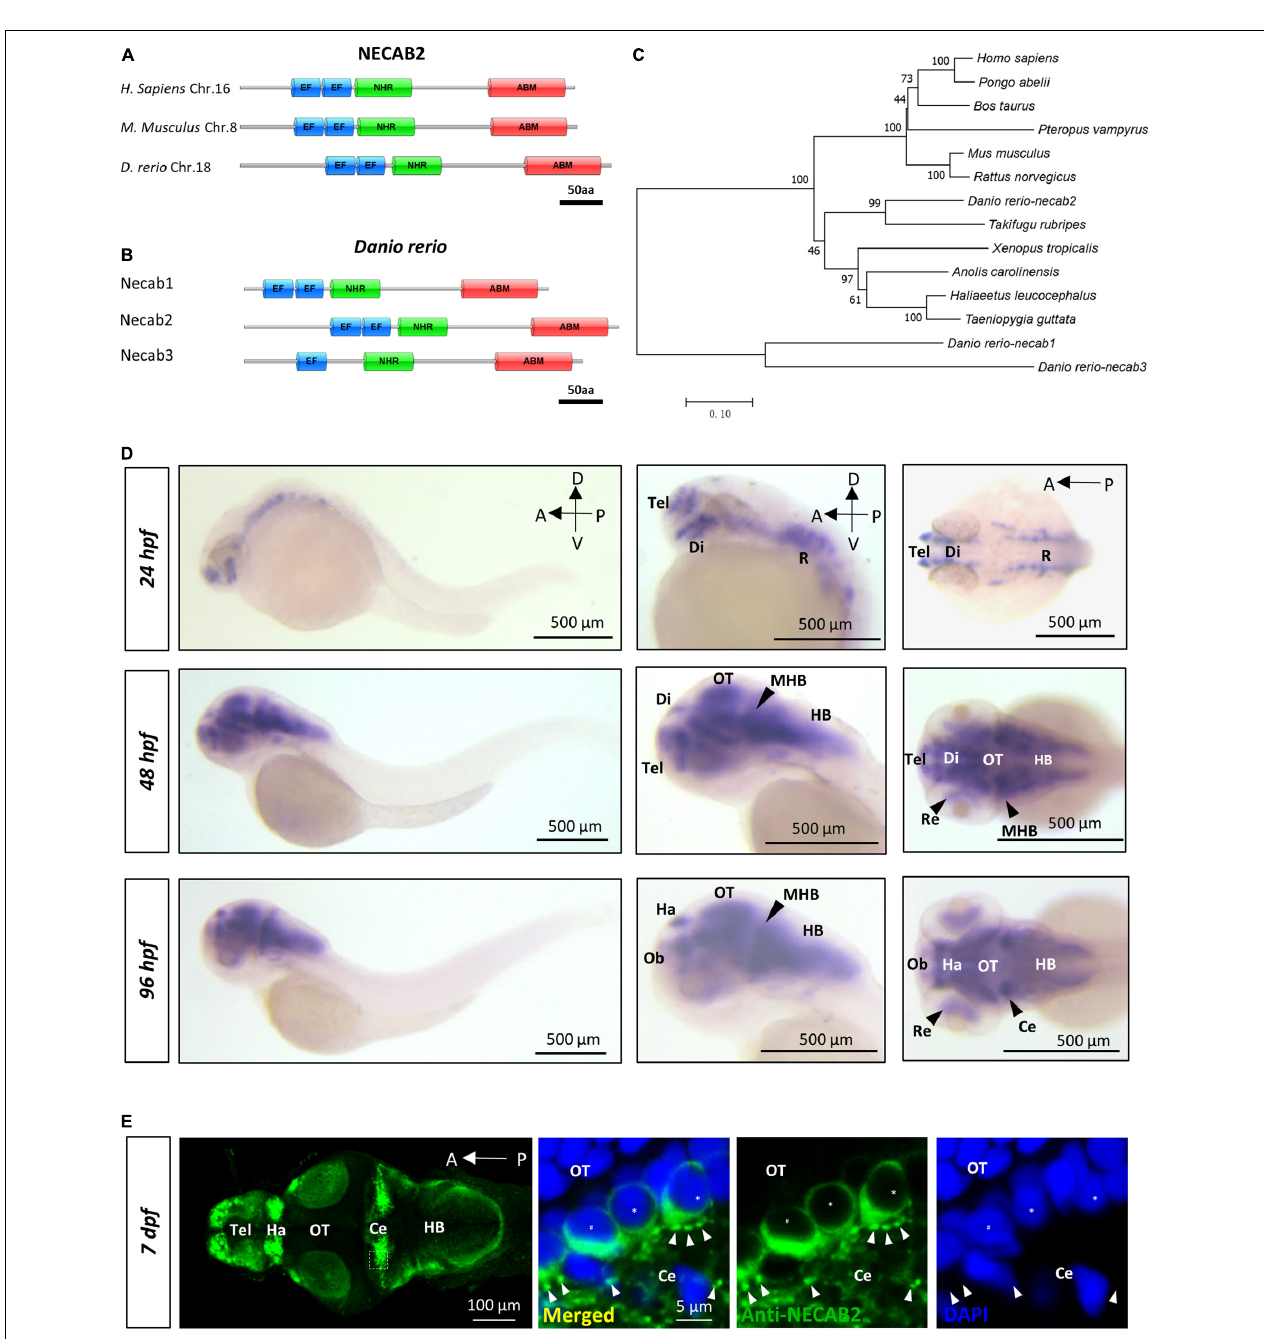
FIGURE 1 | necab2 , conserved in the vertebrate lineage, is expressed in the developing zebrafish brain. (A) Protein Diagrams of NECAB2 orthologs in H. sapiens , M. musculus, and D. rerio . Diagrams represented the longest isoform. The diagrams were denoted by the species name and chromosome number (Chr.) All major functional domains are conserved. Scale bar = 50 amino acids (aa). (B) Protein Diagrams of the Necab family in D. rerio . Diagrams represented the longest isoforms. Diagrams are denoted by the gene name. All the major functional domains were conserved in Necab1, Necab2, and Necab3. Scale bar = 50 amino acids (aa). (C) The phylogenetic tree of the evolutionary relationship of NECAB2 . Diverse animal phyla were identified by a best reciprocal BLAST search with human NECAB2 and were mapped onto a phylogenetic tree. The tree was drawn to scale, with branch lengths in the same units as those of the evolutionary distances. All of the sequences were available from the NCBI protein database. Scale bar = 0.10. (D) Whole-mount in situ hybridization of necab2 in wild-type embryos at 24, 48, and 96 hpf. necab2 was expressed in selected brain regions reminiscent of the locations of nascent neurons. Scale bar = 500 µ m. (E) Whole-mount immunofluorescence of Necab2 in wild-type larvae at 7 dpf. Necab2 was abundant in the telencephalon, habenula, and cerebellum. Scale bar = 100 µ m. Necab2 was detected in structures reminiscent of synapse boutons (arrowheads) and the cell cytoplasm/membrane avoiding the nucleus (asterisks). The region in the dashed white box was shown at a higher magnification on the right. Scale bar = 5 µ m. NECAB2 protein domains: EF, EF-Hand; NHR, NECAB Homologous Region; ABM, Antibiotic Biosynthesis Monooxygenase. hpf, hour post-fertilization; dpf, day post-fertilization; Tel, telencephalon; Di, diencephalon; Ce, cerebellum; Re,